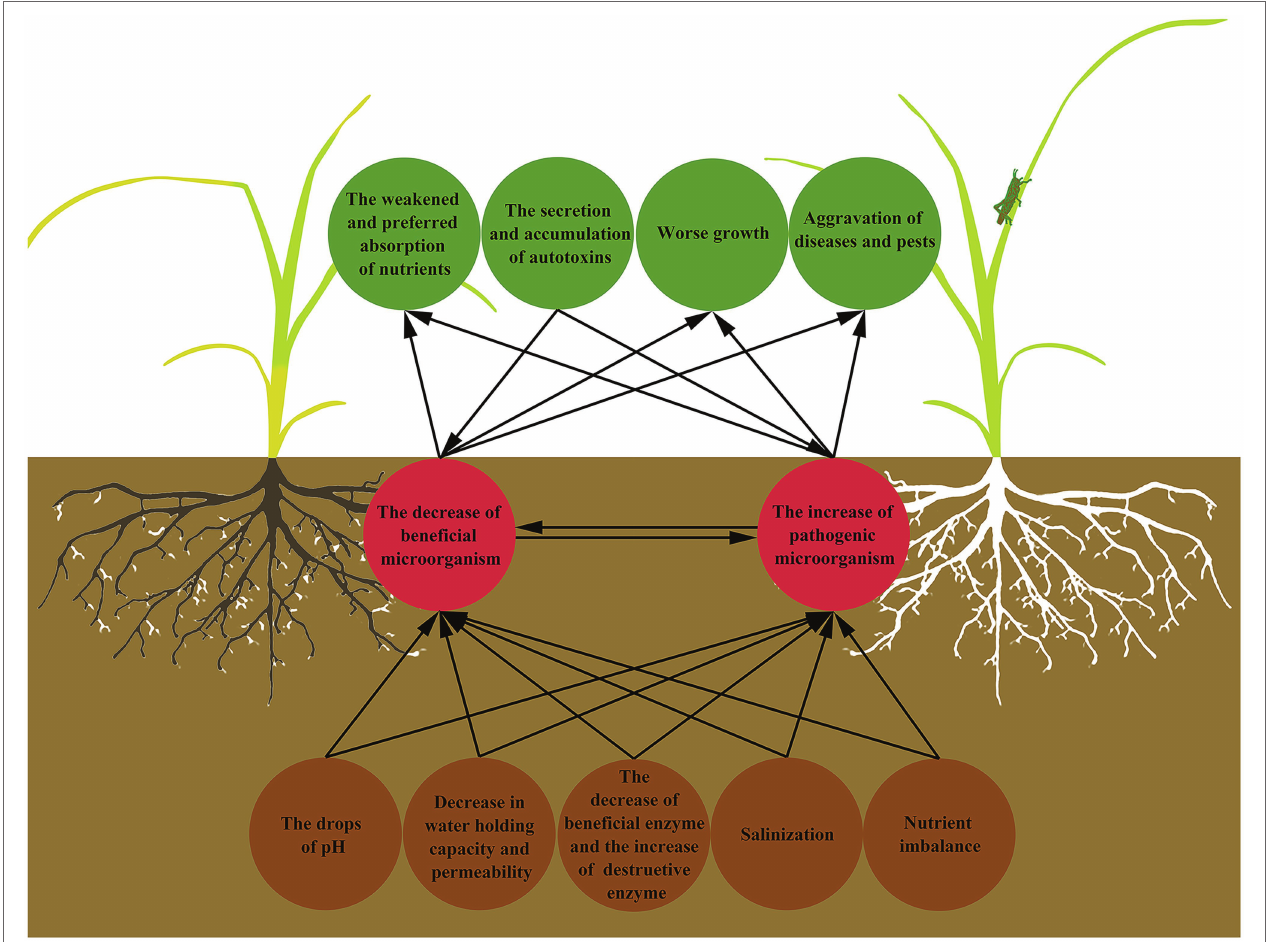
FIGURE 1 | Interactions between the soil microbial community and the manifestation of continuous cropping obstacles. Continuous cropping results in deterioration of soil physical and chemical properties, which further affects the survival, proliferation, and working of soil microorganisms, and destroys soil microbial community structure. When it comes to plants, it is the abnormal growth state, the aggravation of diseases and insect pests, and the weakened and preferred absorption of nutrients. At the same time, the autotoxins secreted by plants affect the soil microorganisms in